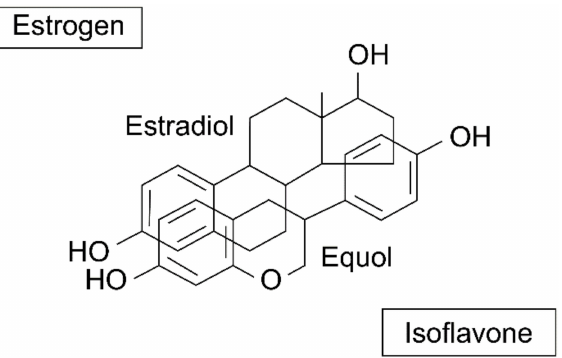
Figure 1. Similarity of isoflavone to estrogen. Reprinted from Setchell, K.D.; Cassidy, A. Dietary Isoflavones: Biological Effects and Relevance to Human Health. J. Nutr. 1999 , 129 , 758–767, with permission. © 1999, Oxford University Press